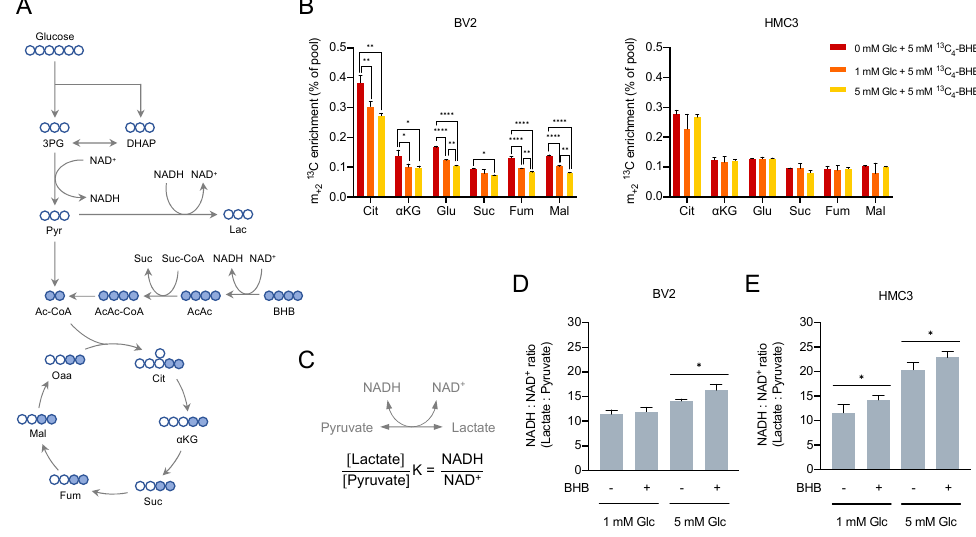
Figure 1. β -hydroxybutyrate (BHB) oxidation in murine (BV2) and human (HMC3) cells. ( A ) Schematic representation of 13 C enrichment derived from 13 C 4 -BHB. ( B ) m + 2 13 C enrichment of TCA cycle intermediates (Cit, citrate; α KG, α -ketoglutarate; Glu, glutamate; Suc, succinate; Fum, fumarate; Mal, malate) in BV2 and HMC3 cells in culture conditions with either no added glucose or 1 or 5 mM of 12 C 6 -glucose and 5 mM 13 C 4 -BHB for 24 h. Bars represent mean ± SD of n = 3 biological replicates. Data were analysed by one-way ANOVA per metabolite followed by Tukey’s test. ( C ) Schematic representation of the cytosolic NADH:NAD + ratio in equilibrium with Lactate:Pyruvate ratio. ( D , E ) Cytosolic NADH:NAD + ratio estimated using the intracellular levels of lactate and pyruvate in BV2 ( D ) and HMC3 ( E ). Bars represent mean ± SD of n = 2–3 (-BHB) and n = 5–6 (+BHB) biological replicates. Data were analysed by two-way ANOVA followed by Sidak’s test (-BHB vs. +BHB within glucose class). Statistical significance is denoted as * p < 0.05, ** p < 0.01 and **** p < 0.0001.